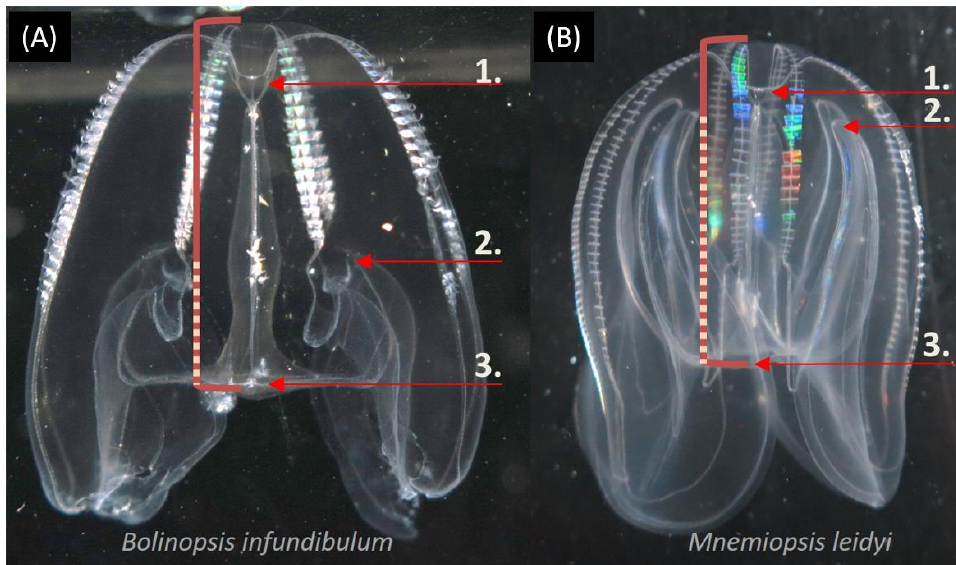
Figure 10. Characteristics of lobate ctenophores present in northern Europe with ( A ) the native Bolinopsis infundibulum and ( B ) the non-indigenous Mnemiopsis leidyi . Morphological differentiation is based on the position of the statocyst: (1) in relation to the insertion of the lobes (2) and the mouth; (3) in B. infundibulum , the distance between insertion of the lobes (2) and mouth (3) is about one-third of the oral-aboral length (red bracket), while it is two-thirds in M. leidyi, as indicated by the dashed line. Image credit: C. Jaspers, Kiel Fjord January 2015.